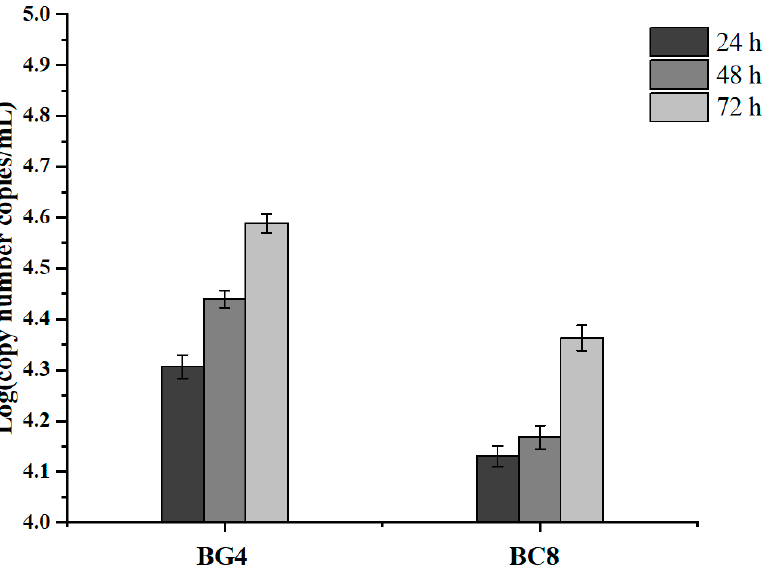
Figure 7. Determination of the orf15 gene expression in CM R negative C. perfringens strains. Strains BG3 and BG4 not infected by the phage were used as control samples. Control wells always showed negative. Data were analyzed using LightCycler ® 480 SW 1.1 software. Mean fold-change values of triplicate independent experiments and standard deviation are shown.